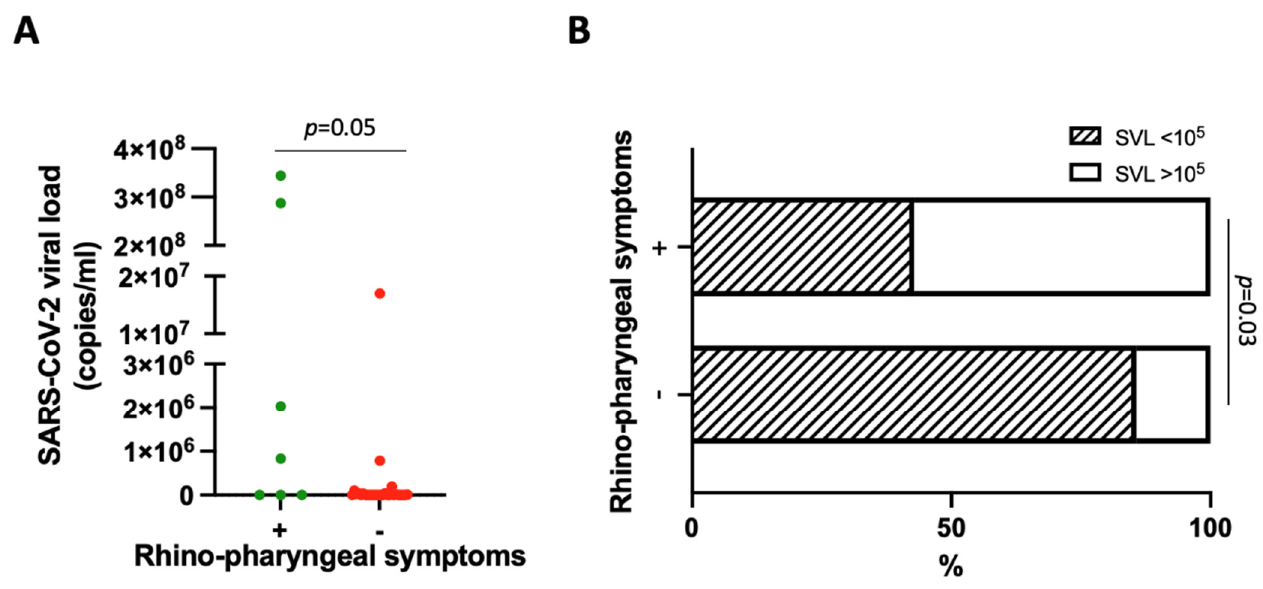
Figure 2. ( A ) SARS-CoV-2 viral load (copies/mL) in patients with [(+): green] and without [( − ): red] nasopharyngeal symptoms. ( B ) Percentage of patients with (+) and without ( − ) nasopharyngeal symptoms displaying SARS-CoV-2 salivary viral load <10 5 and >10 5